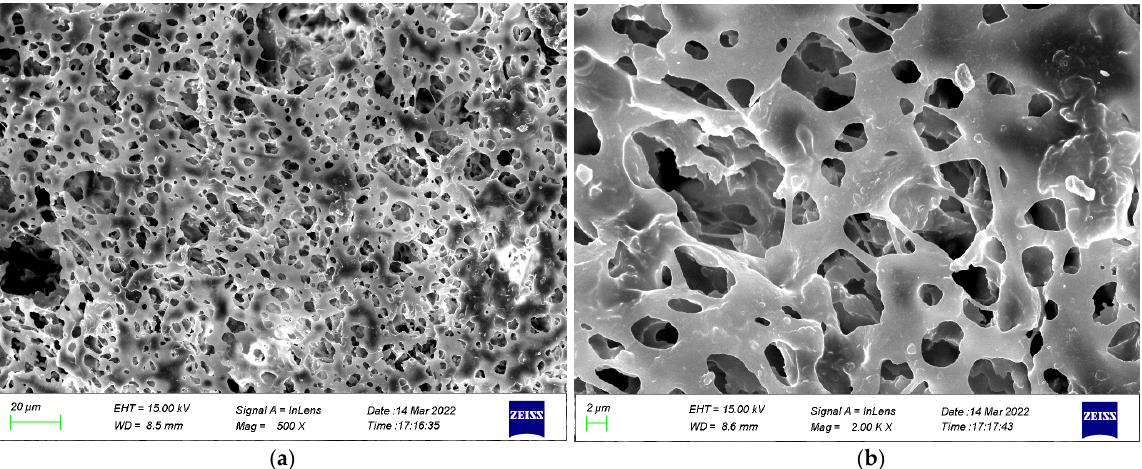
Figure 16. Micro-structure of aggregate, WER content 0%: ( a ) 500×; ( b ) 2000×.